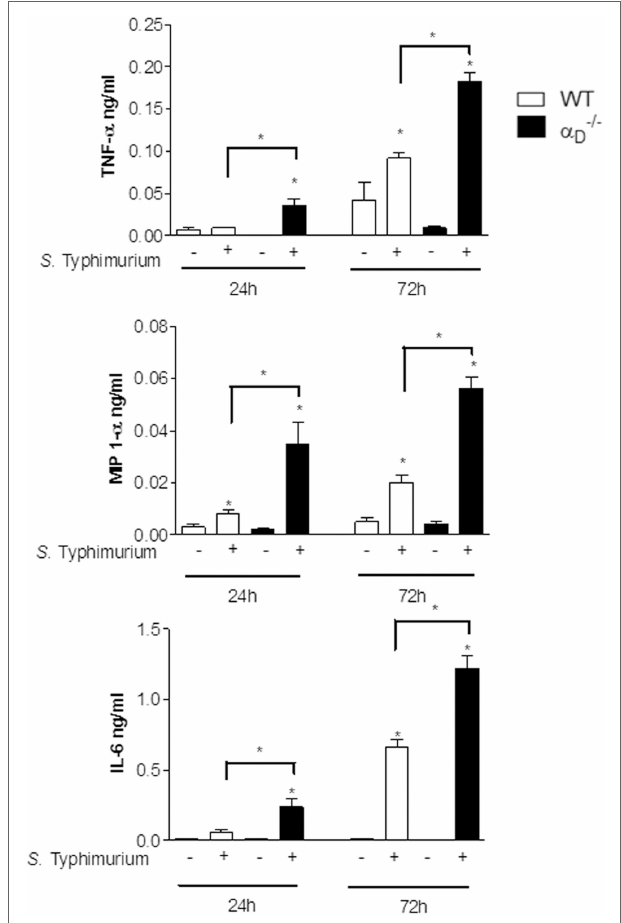
FIGURE 4 | Inflammatory cytokines are increased in the peritoneal fluid of α –/– D mice infected with Salmonella Typhimurium. Wild-type (WT) and α –/– D mice were infected with S. Typhimurium (10 5 CFU/animal) or sham-infected with sterile saline as in Figure 1 . Peritoneal fluid was collected 24 or 72h after challenge, and concentrations of TNF- α , MIP-1 α , and IL-6 were determined. Each bar indicates the mean (cid:6) SEM of determinations in samples from five animals. Significant differences ( p < 0.05) between infected animals and controls are indicated by bars and asterisks as in Figure 1 . The data in this figure are representative of three separate experiments.